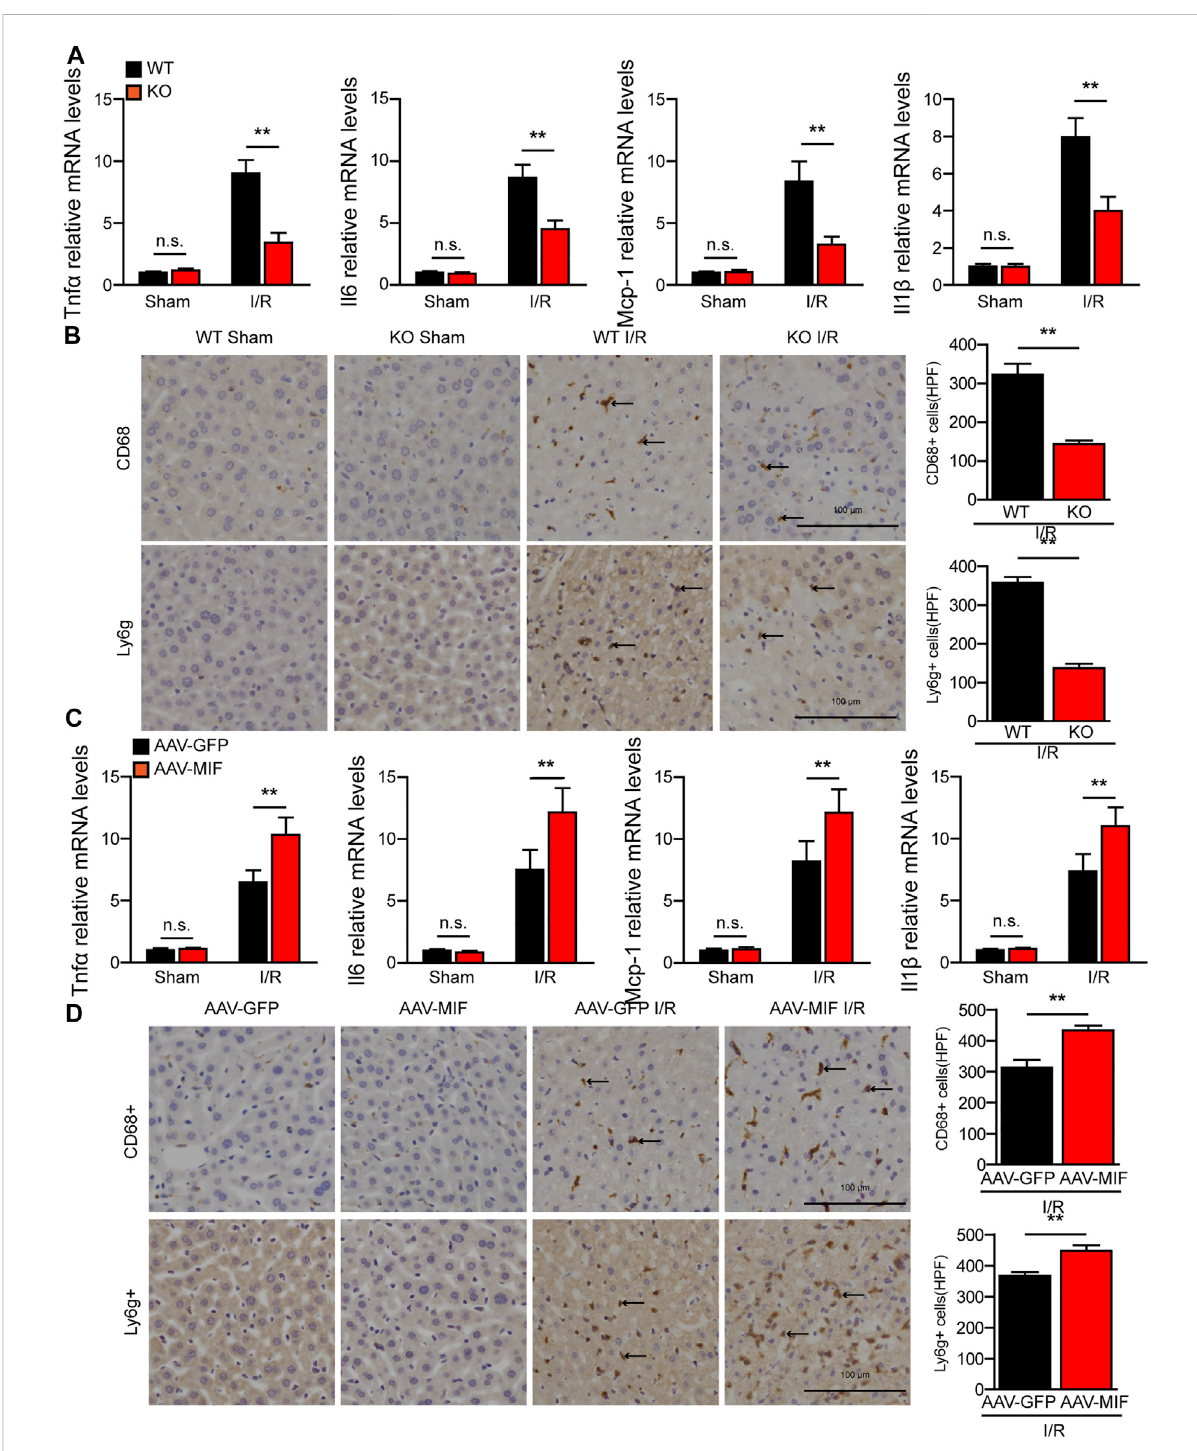
FIGURE 3 MIF promotes in fl ammatory response during hepatic I/R injury. (A) mRNA levels of proin fl ammatory factors ( Tnf α , Il6 , IL1 β , and Mcp-1 ) in the liverofWT and MIF -KOmice after hepaticI/R surgery ( n = 4/group). (B) Representative CD68 andLy6g IHCstaining intheliver lobes ofWTand MIF - KOmiceafterhepaticI/Rsurgery( n =4/group).Scalebar,100 μ m.Markedbyblackarrow. (C) mRNAlevelsofproin fl ammatoryfactors( Tnf α , Il6 , IL1 β , and Mcp-1 )intheliverofAAV-GFPorAAV-MIF miceafter hepaticI/R injury( n =4/group). (D) RepresentativeCD68 andLy6gIHCstaininginthe liver of AAV-GFP or AAV-MIF mice after hepatic I/R injury ( n = 4/group). Scale bar, 100 μ m. Marked by black arrow. All data are presented as the mean ± SD. Levels of statistical signi fi cance are indicated as** p < 0.01 and n. s = not signi fi cant. For statistical analysis, one-way ANOVA with Bonferroni ’ s post hoc analysis or Tamhane ’ s T2 post hoc analysis and two-tailed Student t test were